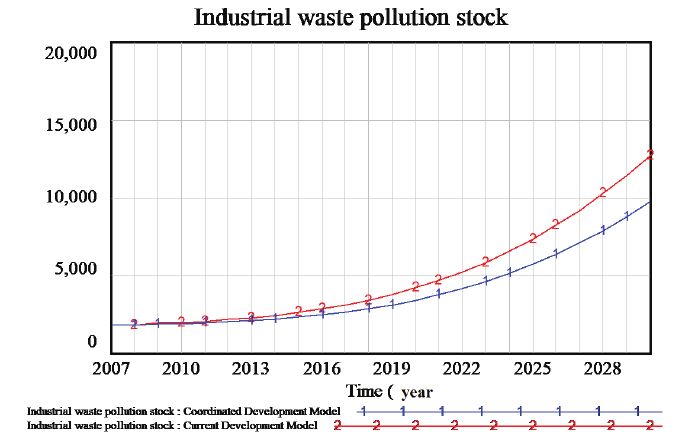
Fig. 6 Industrial waste gas pollution quantity analog value(100 million cubic meters)